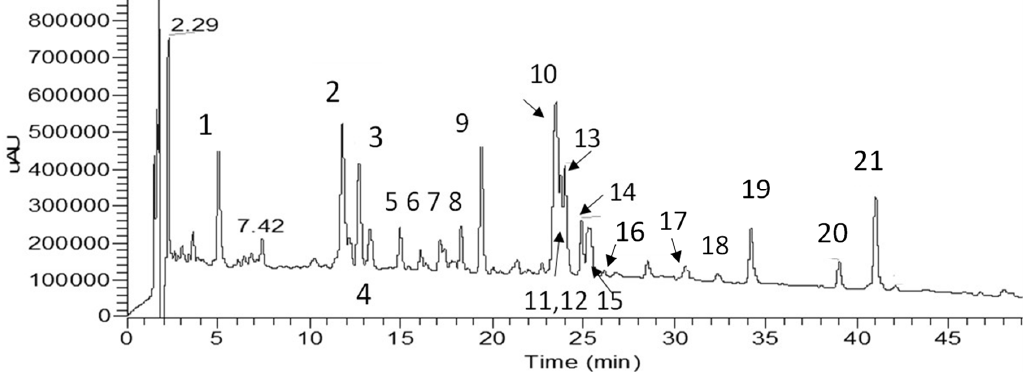
Figure 2. Representative HPLC–PDA–MS chromatogram of the MeOH extract of Matricaria pubescens flowers. Experimental conditions: column: Zorbax SbAq RP-C18 (150 × 3.0 mm), particle size of 5 µ m (Agilent) at 30 ◦ C. Compounds detected: chlorogenic acid ( 1 ), quercetagenin-3-O-glucoside ( 2 ),